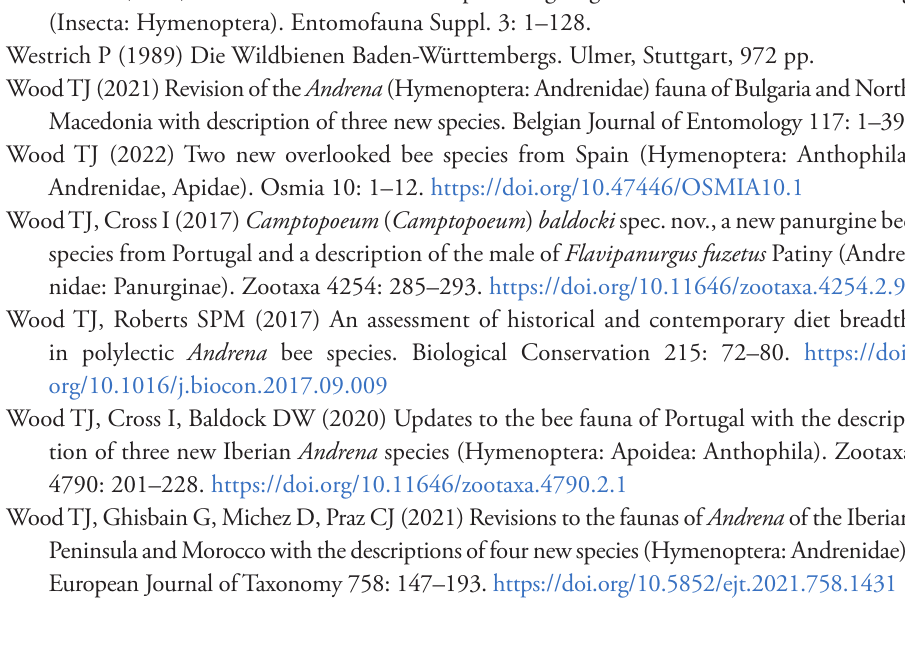
Explanation note: Table S1. Specimens used in genetic analyses. The unique identifiers are identical to the Sample-ID on BOLD. The primers used in PCR and the size of the fragment sequenced are indicated (primer names are abbreviated; see text). GenSeq category after Chakrabarty et al. 2013, Zookeys 346: 29–41 (1 =